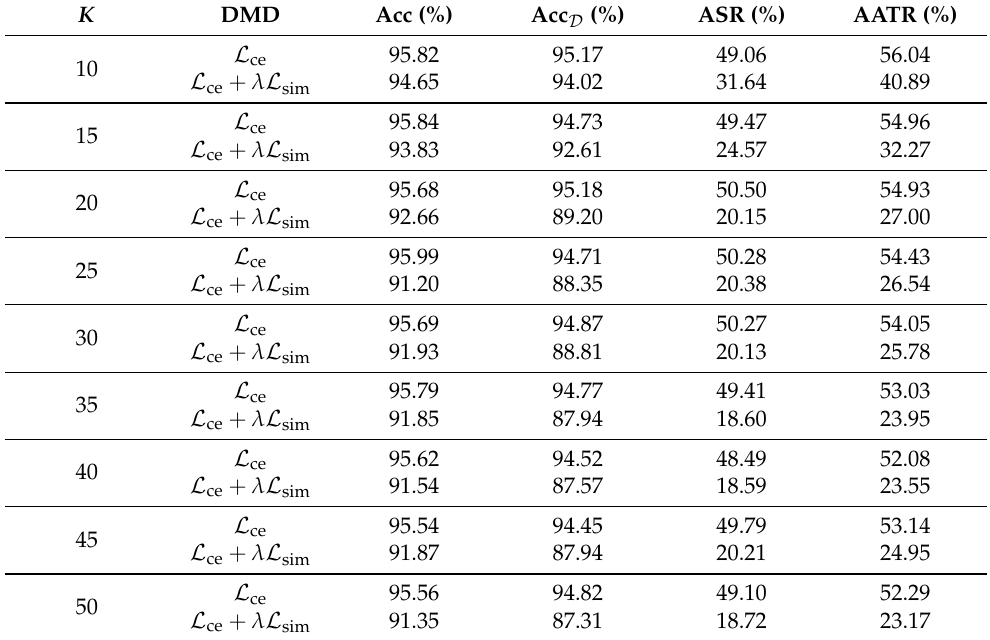
Table 3. Ablation study of the two different DMD steps on MNIST. L ce denotes the case where we only use adversarial sample-based model differentiation, and L ce + λ L sim specifies the case of combining sub-federated model-based model differentiation with adversarial samples based model